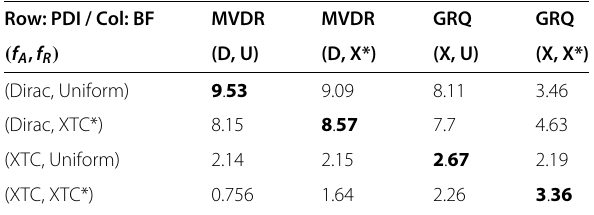
Table 3 Beamformer cross-density probabilistic directivity